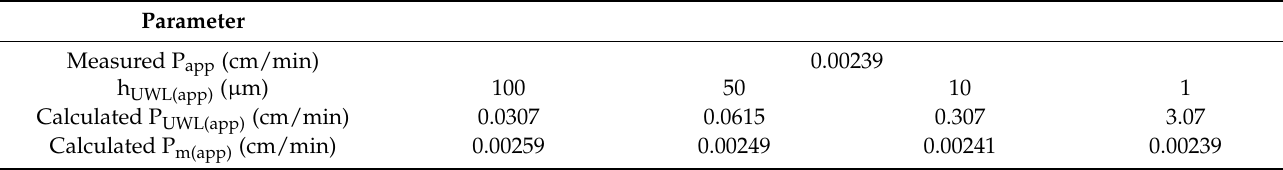
Table 3. Calculated permeability of